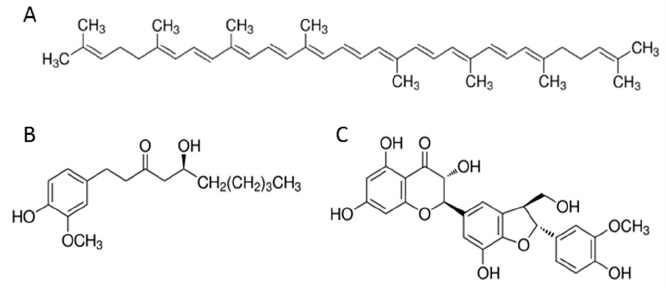
Figure 1. Chemical structure of tested compounds: ( A ) lycopene; ( B ) [6]-gingerol; ( C )